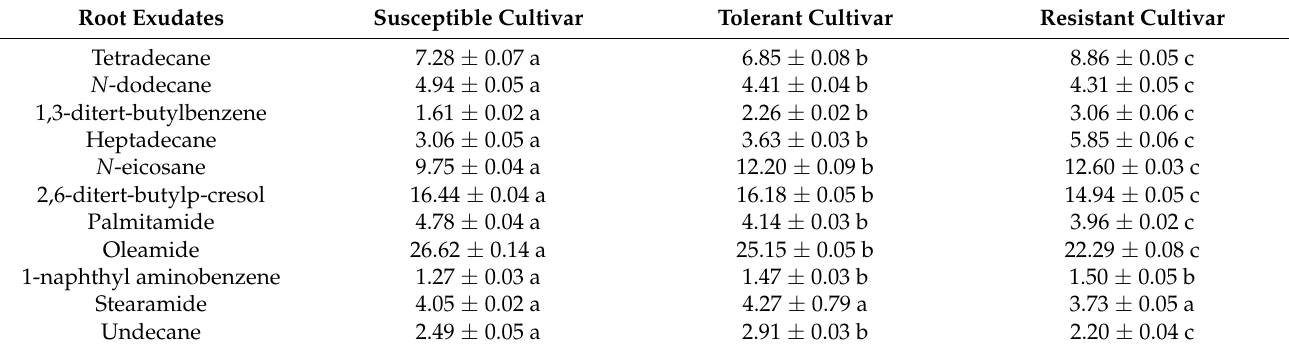
Table 1. The root exudates with significant differences between the three tomato